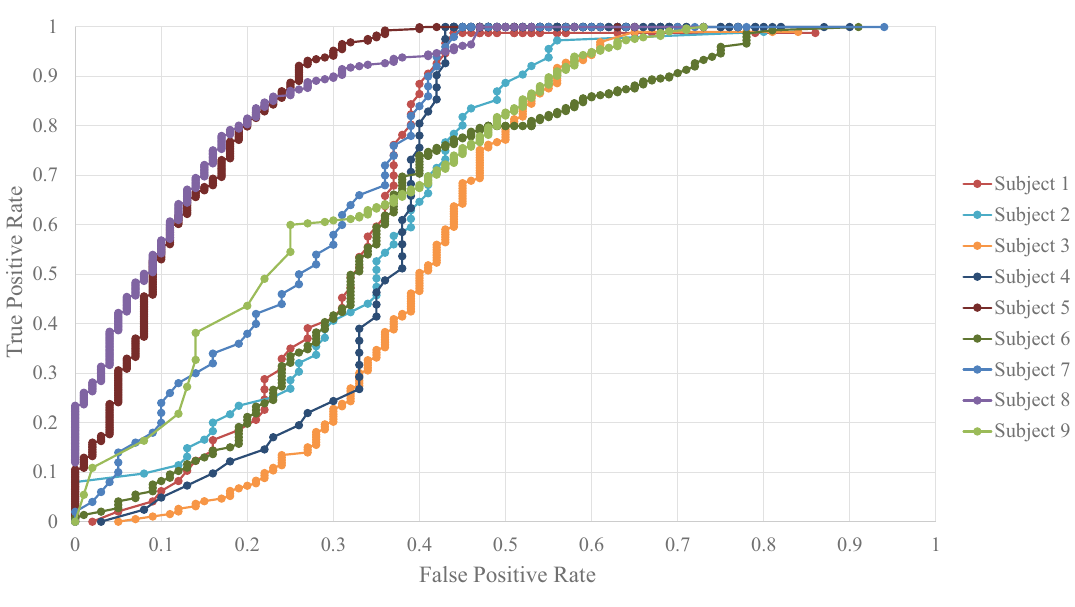
Figure 6. Receiver operating characteristic (ROC) curves of each subject for the CNN model with one layer, convolution patch [4 × 1] and pool patch [3 × 2] using the single-subject